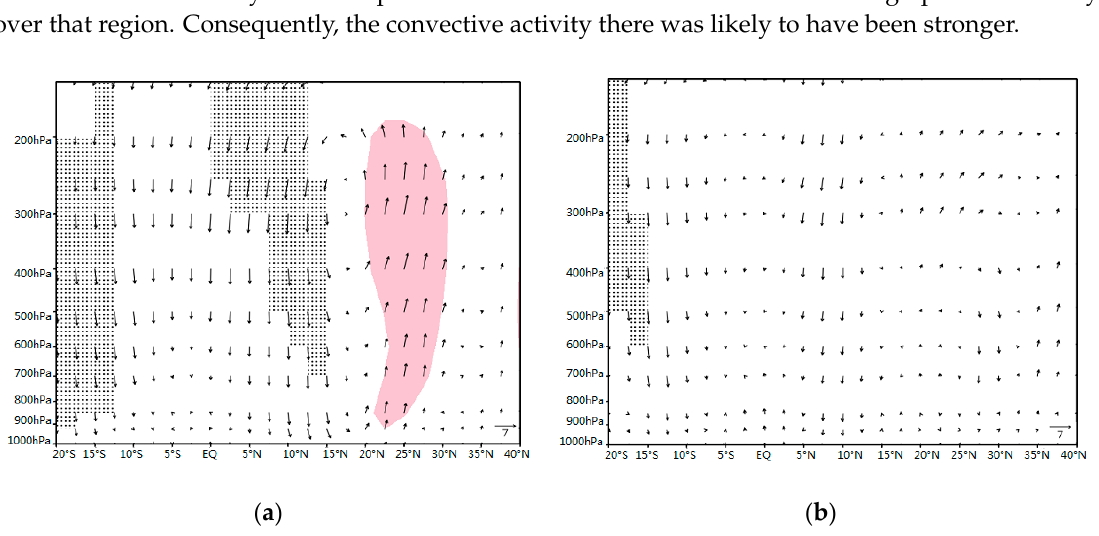
Figure 6. Composite anomalies of latitude–pressure cross-sections of meridional circulations (vectors) averaged along 110 ◦ E–130 ◦ E during DJF 1979–2016 for the ( a ) spring and ( b ) summer El Niño events. The units for meridional wind and vertical motion are m · s − 1 and hPa · s − 1 , respectively. The values of vertical velocity are multiplied by − 300. Shaded areas have an upward vertical velocity of ≥ 0.01 hPa · s − 1 . Dotted areas indicate statistically significant vertical velocity at the 95% confidence level, based on the Student’s t -test.